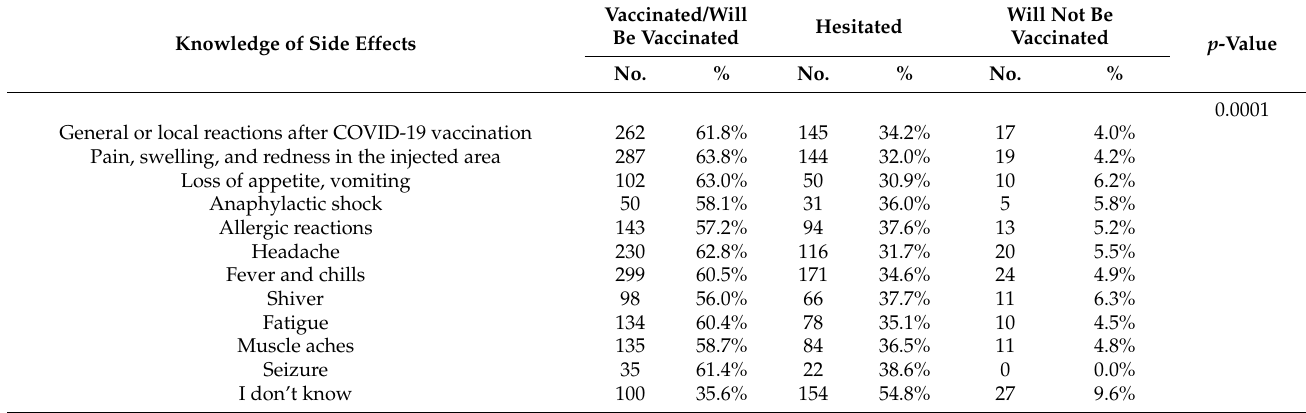
Table 8. Respondents’ knowledge of vaccine side effects measured by willingness to be vaccinated for COVID-19.